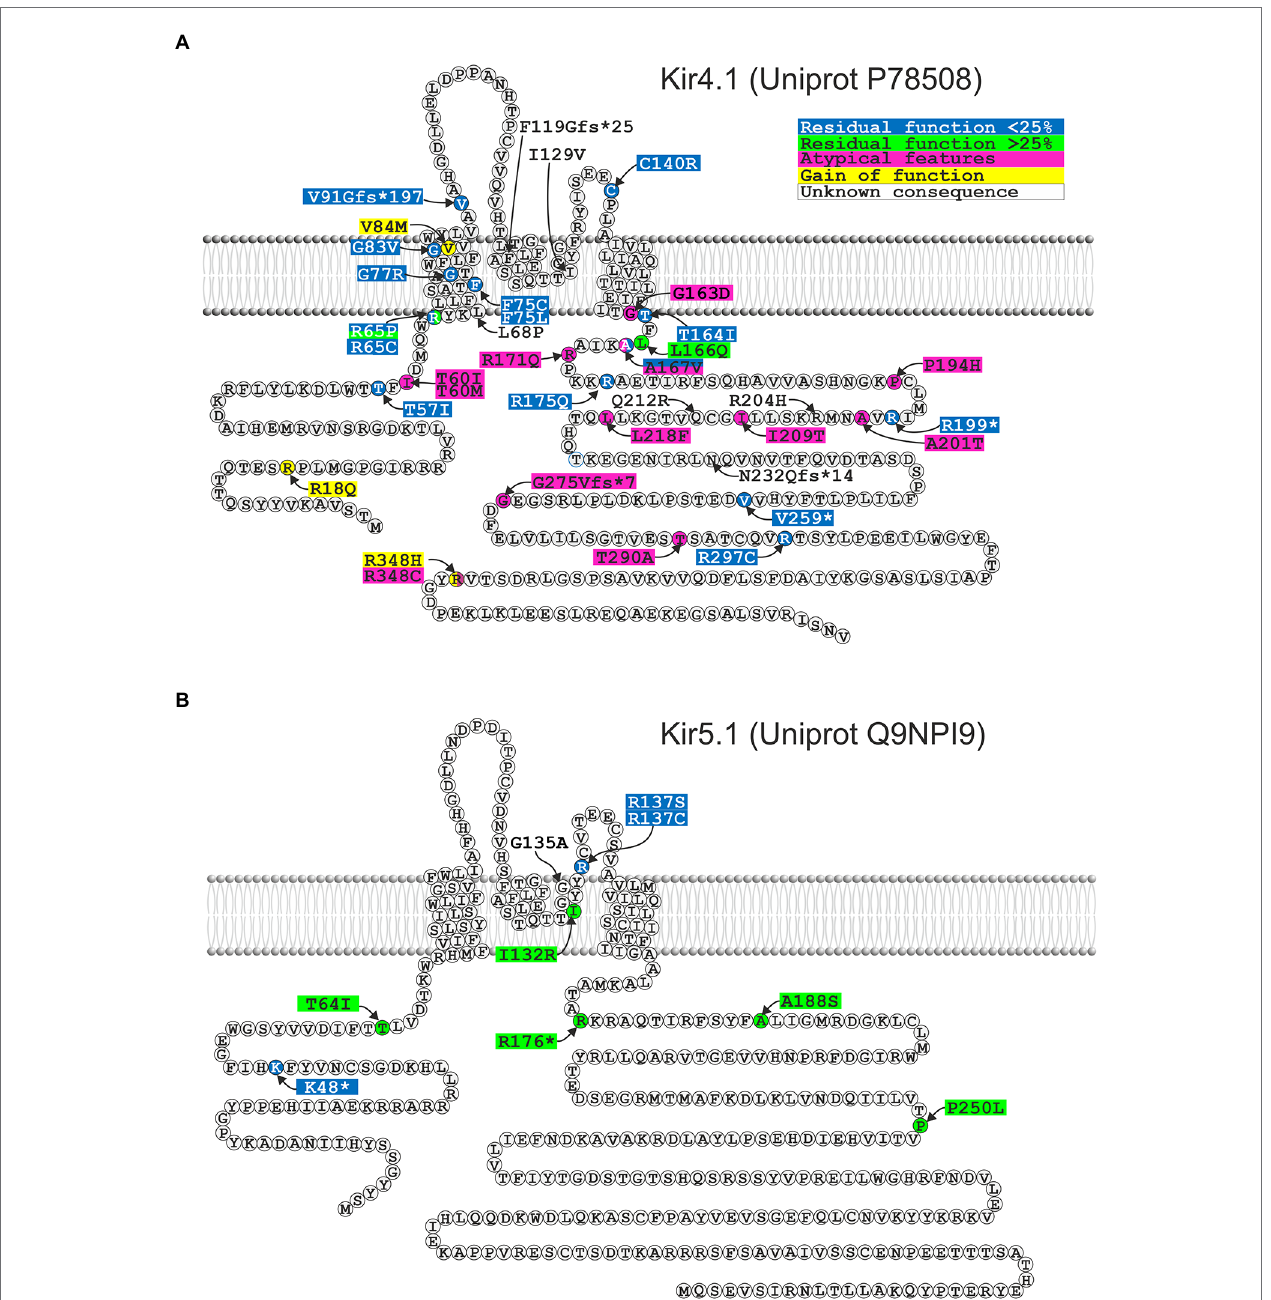
FIGURE 6 | Localization of disease-associated mutations in human Kir4.1 (A) and Kir5.1 (B) . Functional consequences of Kir5.1 mutations were determined by coexpression with Kir4.1. Please note that functional deficits were more pronounced when Kir5.1 was coexpressed with Kir4.2 (Schlingmann et al., 2021; Neubauer et al., 2022). For more detailed information see Tables 1 and 2